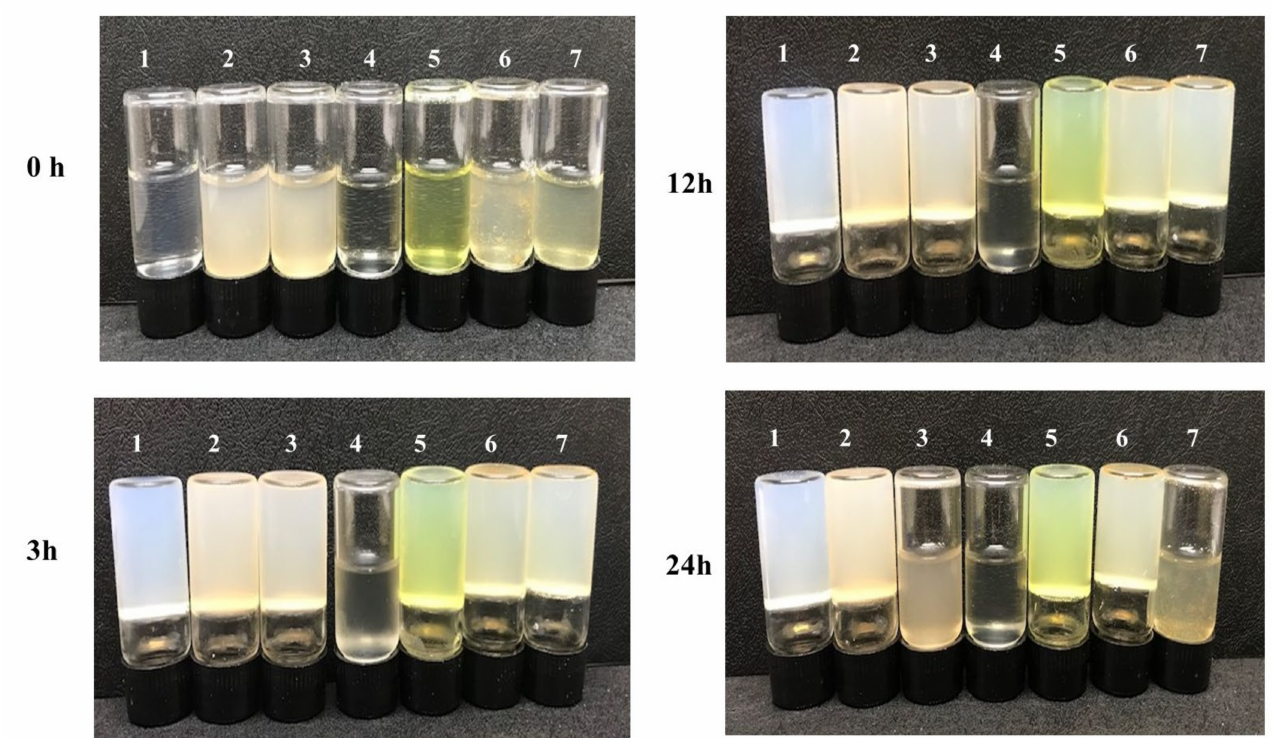
Figure 7. Gelatin solution cocultured with each sample at 37 ◦ C and then stored at 4 ◦ C for 3, 12 or 24 h; ( 1 ) pure gelatin; ( 2 ) MIL-100 capsule; ( 3 ) COL@MIL-100 capsule; ( 4 ) collagenase; ( 5 ) MTX; ( 6 ) MTX@MIL-100 capsule and ( 7 ) MTX@COL@MIL-100 capsule.